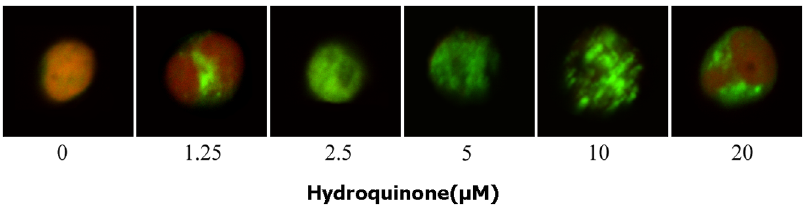
Figure 10. DSB repair induced by HQ in BM-HSC. Representative microscopic fluorescence images of c -H2AX foci accumulation after HQ treatment for 6 h. Nuclei were stained using PI and Al-exa488-labeled secondary antibodies, and were examined by confocal microscopy (oil, 200 6 ). The experiments were repeated for three more times. Green fluorescence indicates formation of c -H2AX foci.